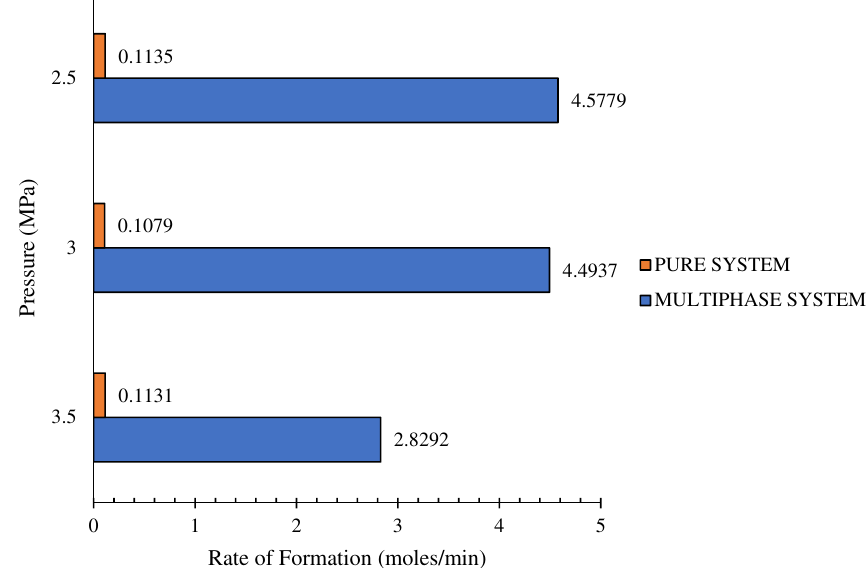
Figure 8. Kinetic performance of pure and multiphase systems.